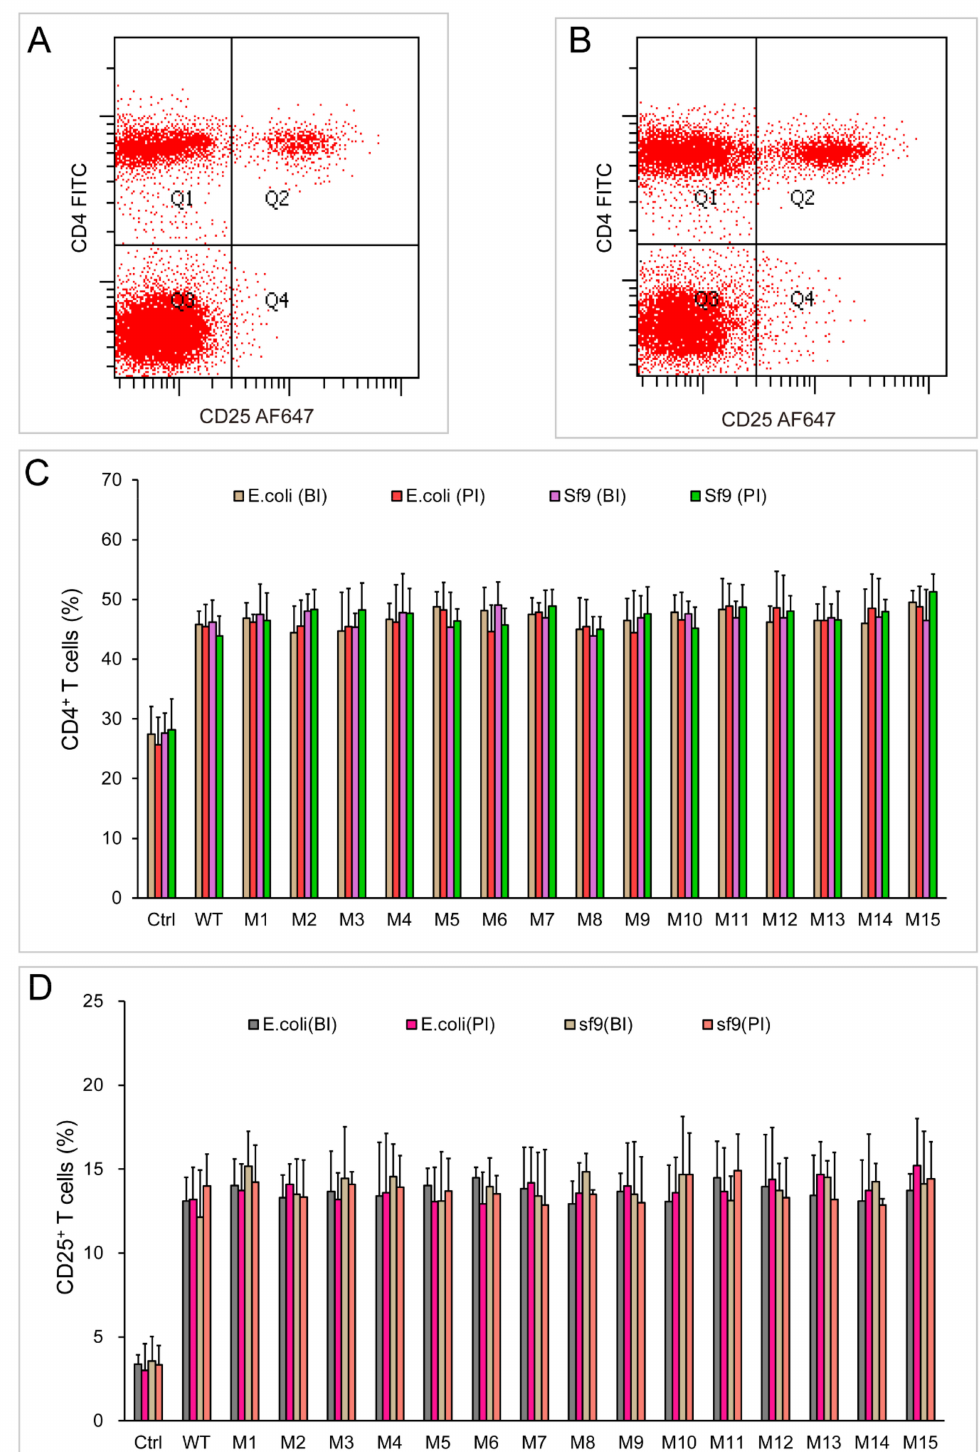
Figure 7. Stimulation assay of chIL-2 monomer and dimer in vivo. ( A ) and ( B ), immunofluorescence analysis of CD4 + and CD25 + T cells by flow cytometry using FITC-conjugated anti-CD4 (CD4 FITC) and Alexa Fluor 647-conjugated anti-CD25 (CD25 AF647) antibodies before ( A ) or post ( B ) stimulation of chIL-2. ( C ), the bar graph of CD4 + T cell proportions; ( D ), the bar graph of CD25 + T cell proportions; BI, chIL-2 protein was not treated with incubation at 37 ◦ C; PI, chIL-2 was treated with incubation at 37 ◦ C. The plotted data represent mean values ± standard deviation, and are the average of three independent